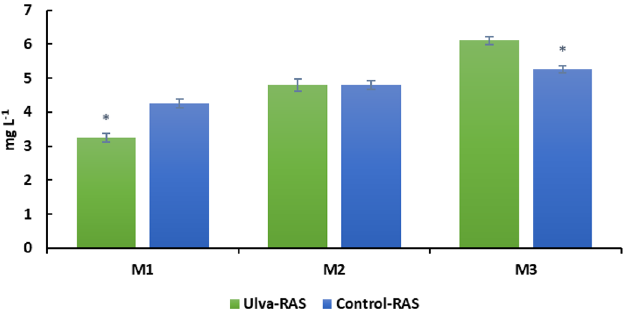
) measured in 4 Fig. 4. The N-nutrients reduction ef fi ciency was calculated for Ulva and gravel bio fi lter in Ulva -RAS, expressed as percentage of the difference of nutrient concentration in water.